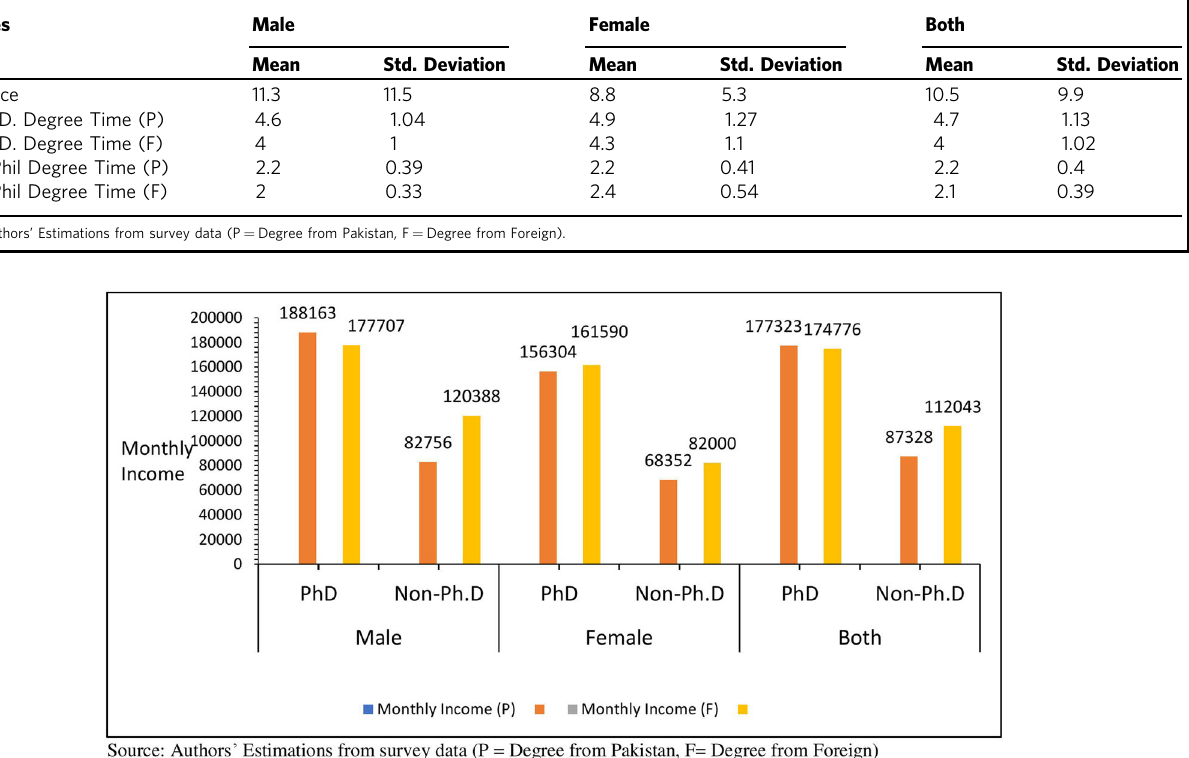
Fig. 4 Average monthly income by education and gender (PKR). It shows the average monthly income of Ph.D. and non-Ph.D. male and female faculty